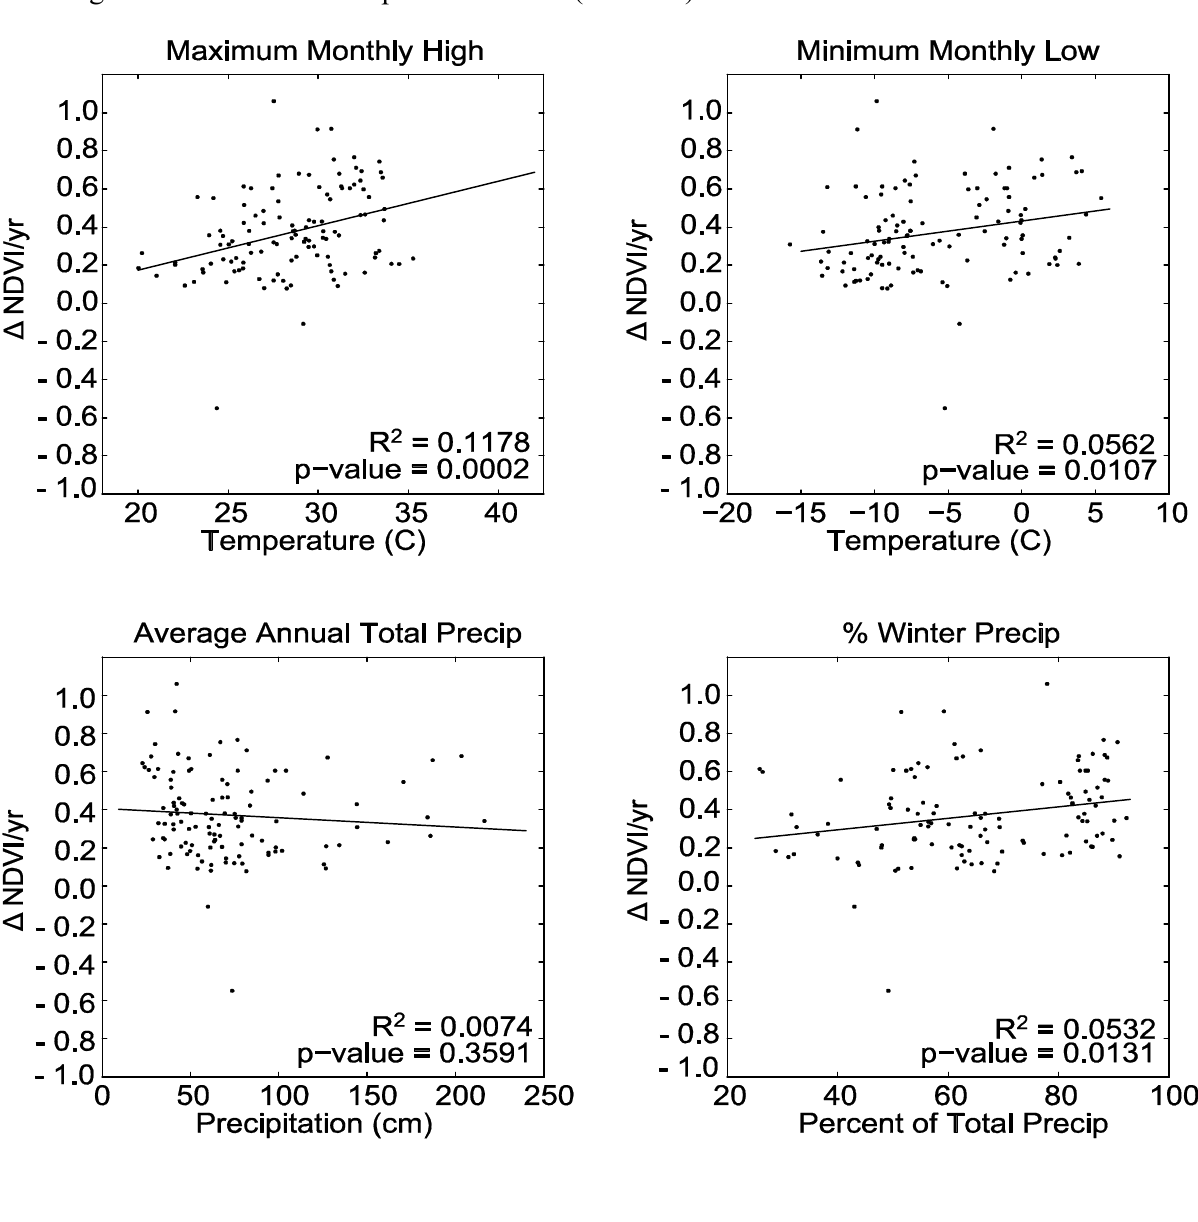
Figure 6. Scatterplots and least squared regression lines for the relationship between regional-scale factors and post-fire NDVI ( Δ